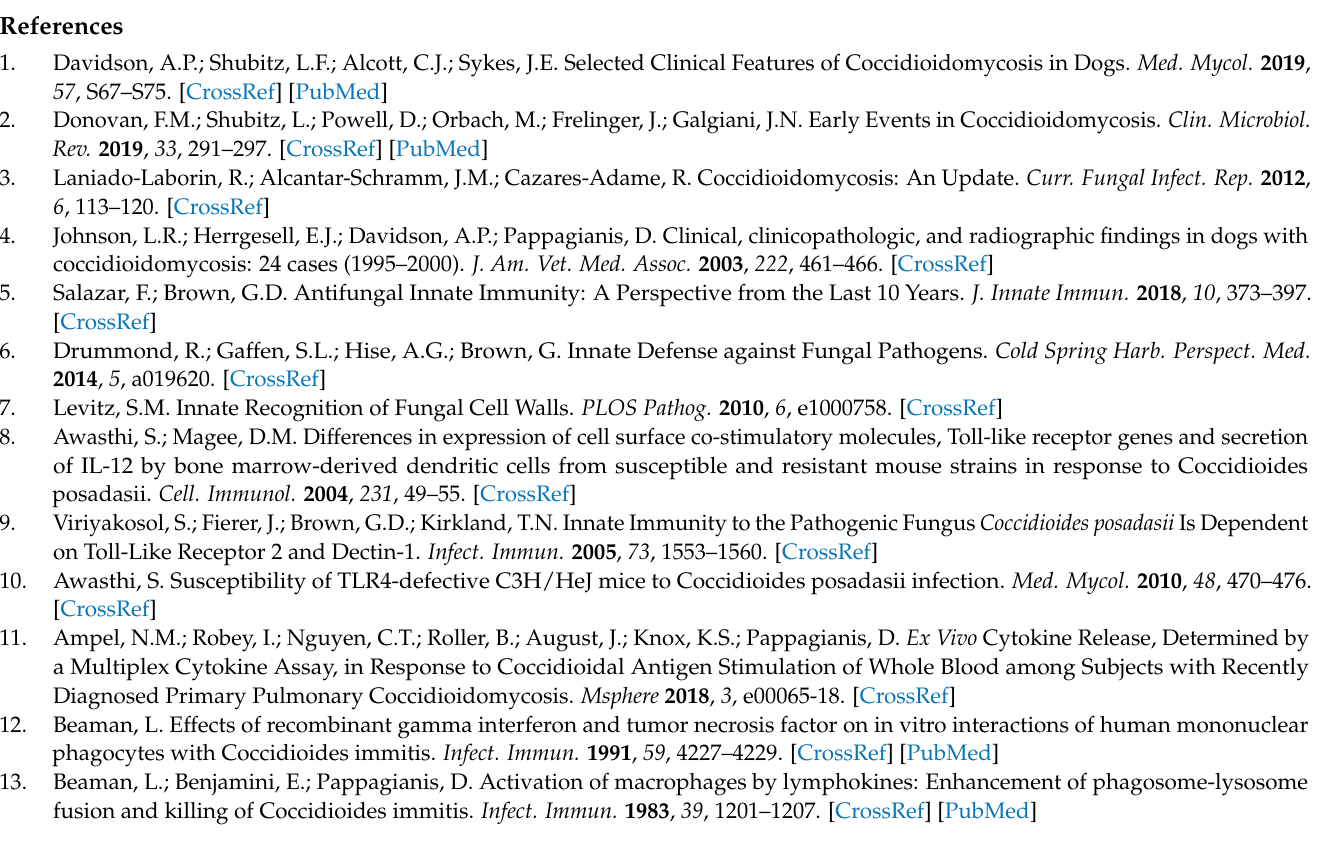
27 dogs with coccidioidomycosis and 10 healthy controls. Table S2: Comparison of constitutive plasma cytokine concentrations in 15 dogs with pulmonary and 12 dogs with disseminated coccidioidomycosis. Table S3: Comparison of rCTS1 antigen-stimulated supernatant cytokine concentrations in 16 dogs with pulmonary coccidioidomycosis and 12 with disseminated disease. Table S4: Comparison of constitutive and rCTS1 antigen-stimulated leukocyte expression of toll-like receptor (TLR)-2 and TLR4 in 12 dogs with pulmonary coccidioidomycosis and 10 dogs with disseminated